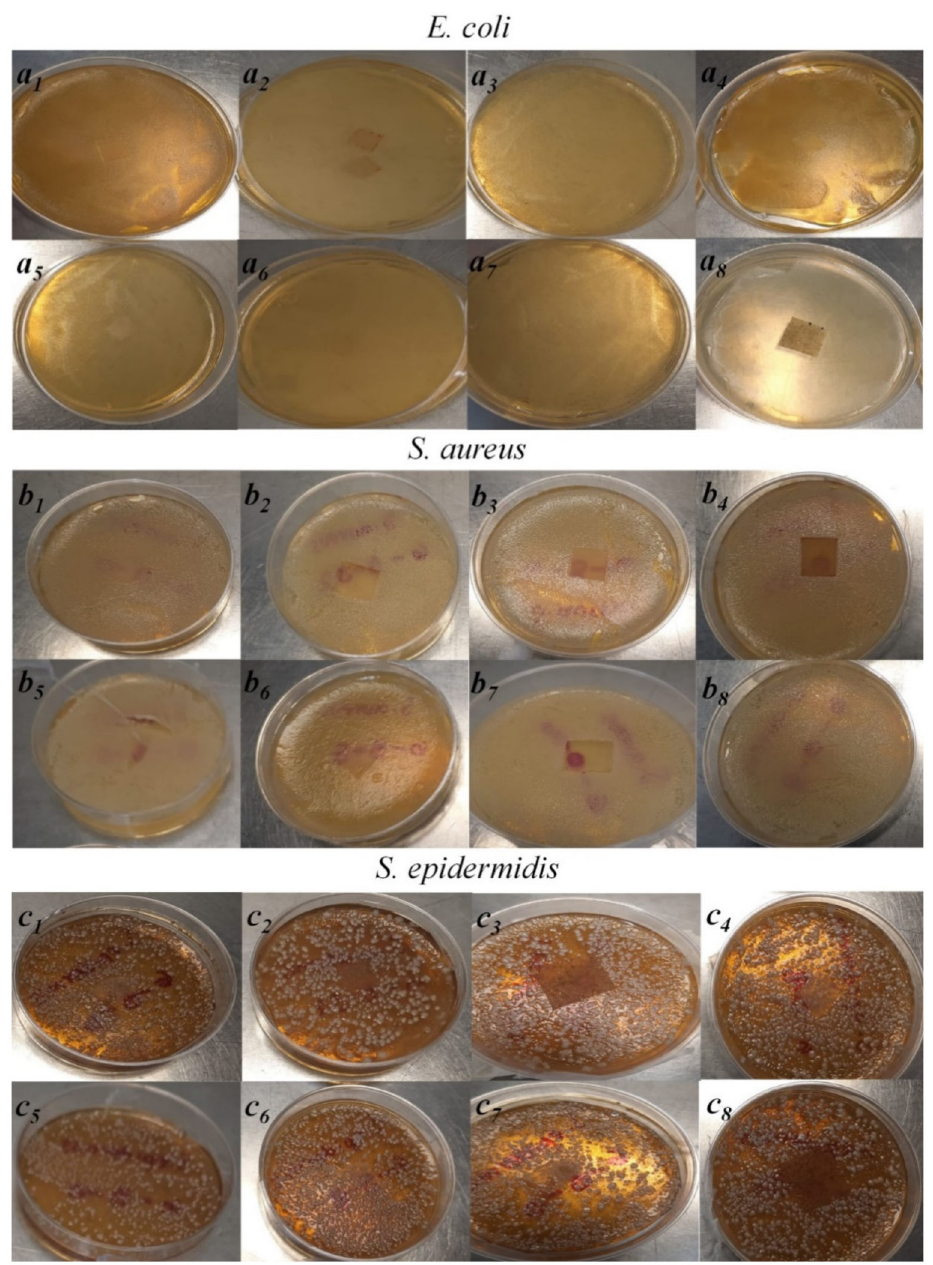
Figure 9. Antimicrobial activity of PVA/HC/EEHP electrospun membranes (Nomenclature: % PVA (6)—% hydrolyzed collagen (0, 5)—% EEHP (0, 8, 16,